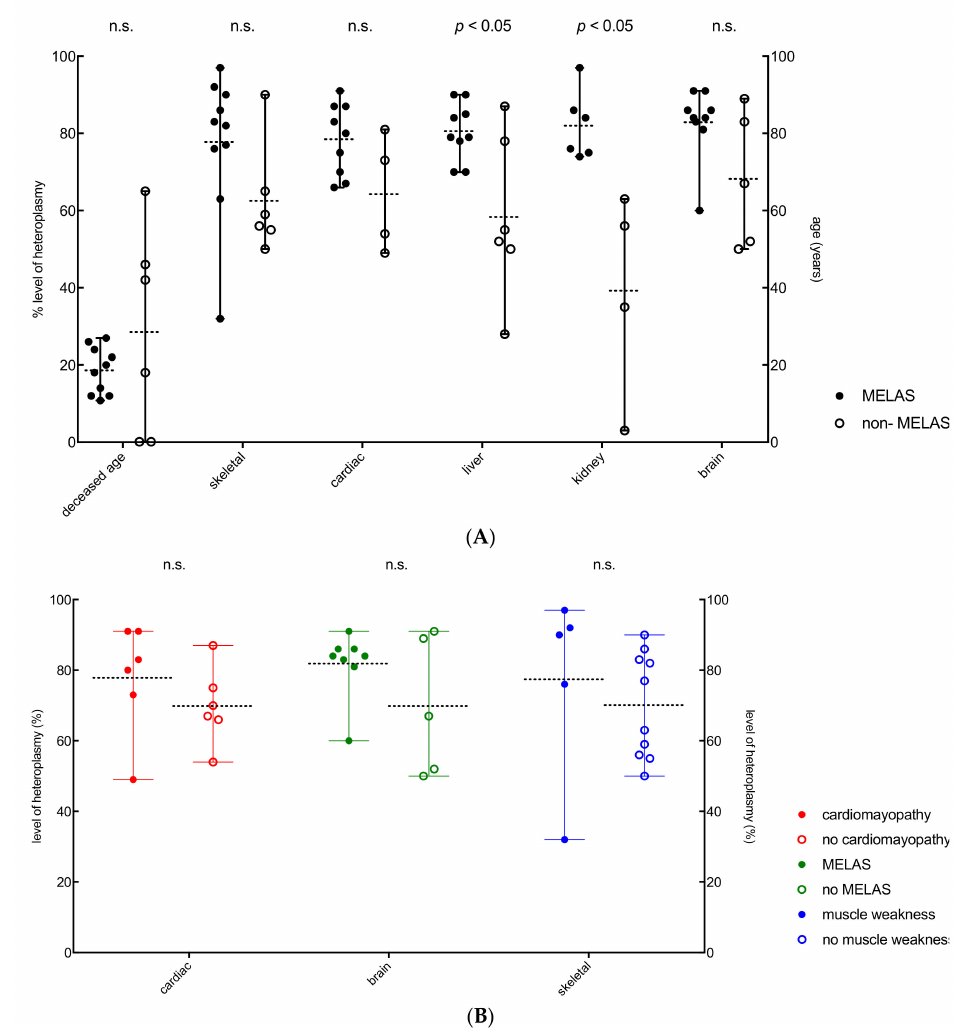
Figure 4. ( A ) Heteroplasmy levels (%) of skeletal, cardiac and brain between MELAS and non-MELAS phenotype patients. Liver and kidney heteroplasmy levels were significantly di ff erent in MELAS (closed circles) and non-MELAS (open circles) phenotype patients. Liver ( p < 0.05) and kidney ( p < 0.05) heteroplasmy levels were significantly higher in the MELAS patients. ( B ) Heteroplasmy levels (%) of cardiac, brain and skeletal in clinically a ff ected (closed circles) and una ff ected patients (open circles), showing no significant di ff erence between a ff ected and una ff ected